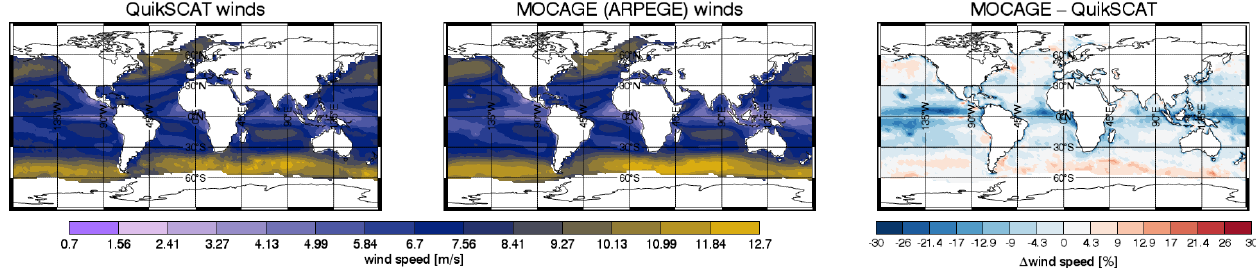
Figure 1. Mean annual surface winds for 2007: left – QuikSCAT measurements, middle – ARPEGE analysis, and right – their relative